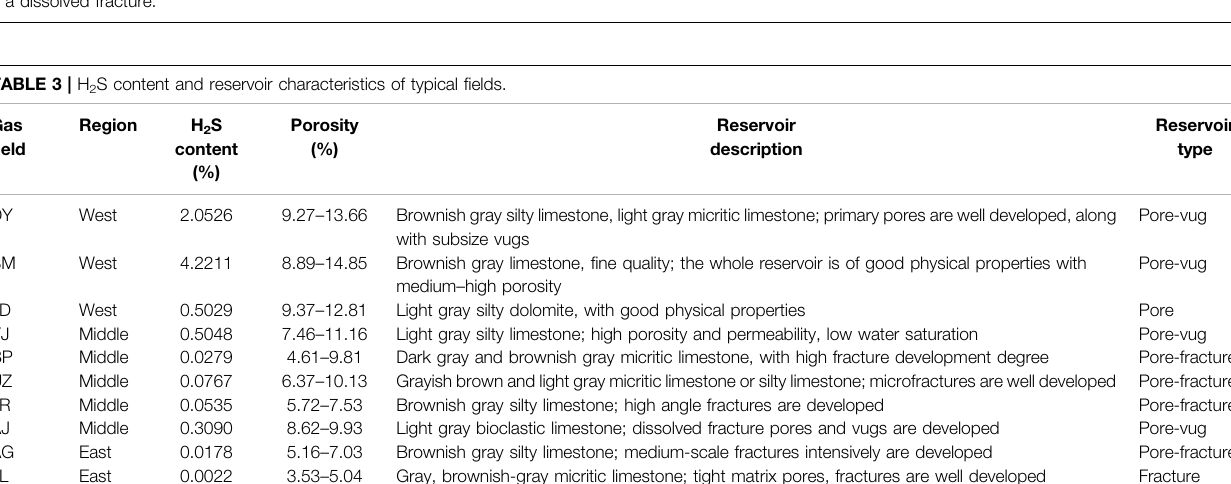
FIGURE12| TheSEMimagesofcoresamples. (A) WellDY-21,showingamoldicvug; (B) WellAJ-21,developingwithintercrystalpores; (C) BL-22Well,showing a dissolved fracture.